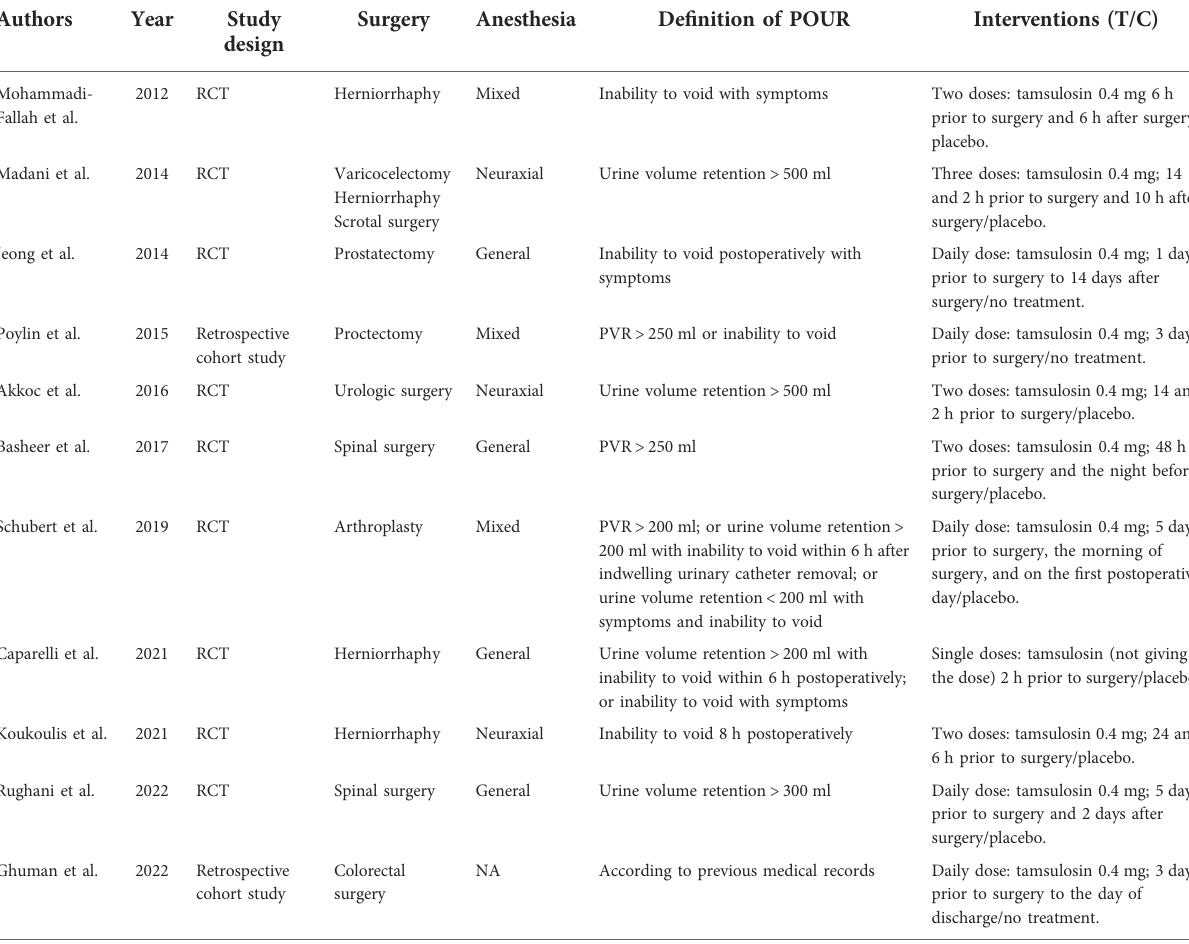
TABLE 1 Characteristics of included